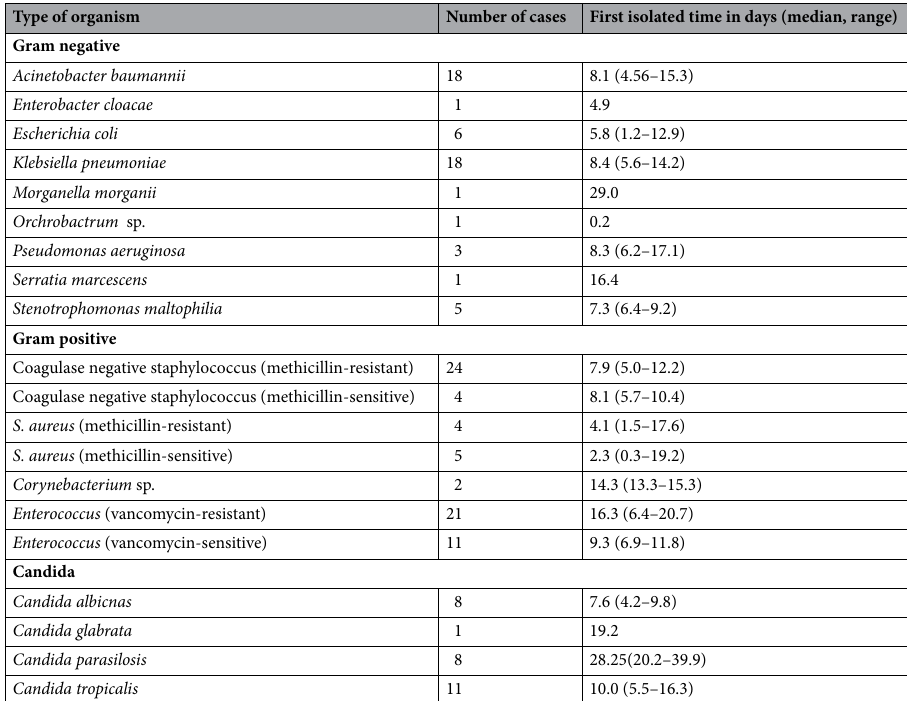
Type of organism Number of cases First isolated time in days (median,